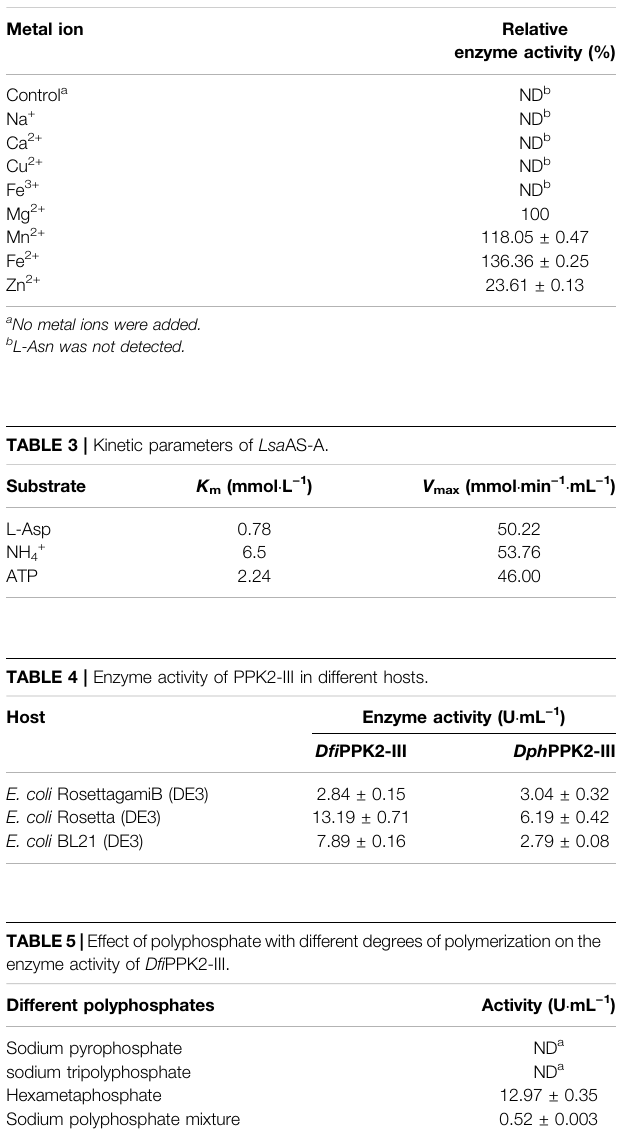
TABLE 2 | Effect of metal ions on the activity of Lsa AS-A.